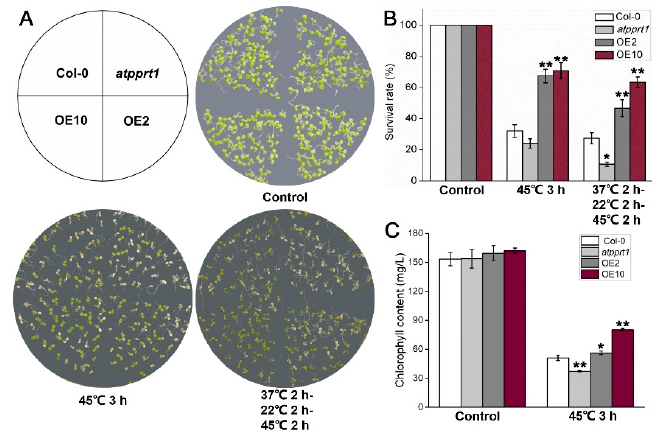
Figure 2. AtPPRT1 enhances the thermotolerance of Arabidopsis seeds during germination. ( A , B ) Germination rate of each line after heat stress. Error bars represent ± SD ( n = 50, * p < 0.05, ** p < 0.01, t -test).